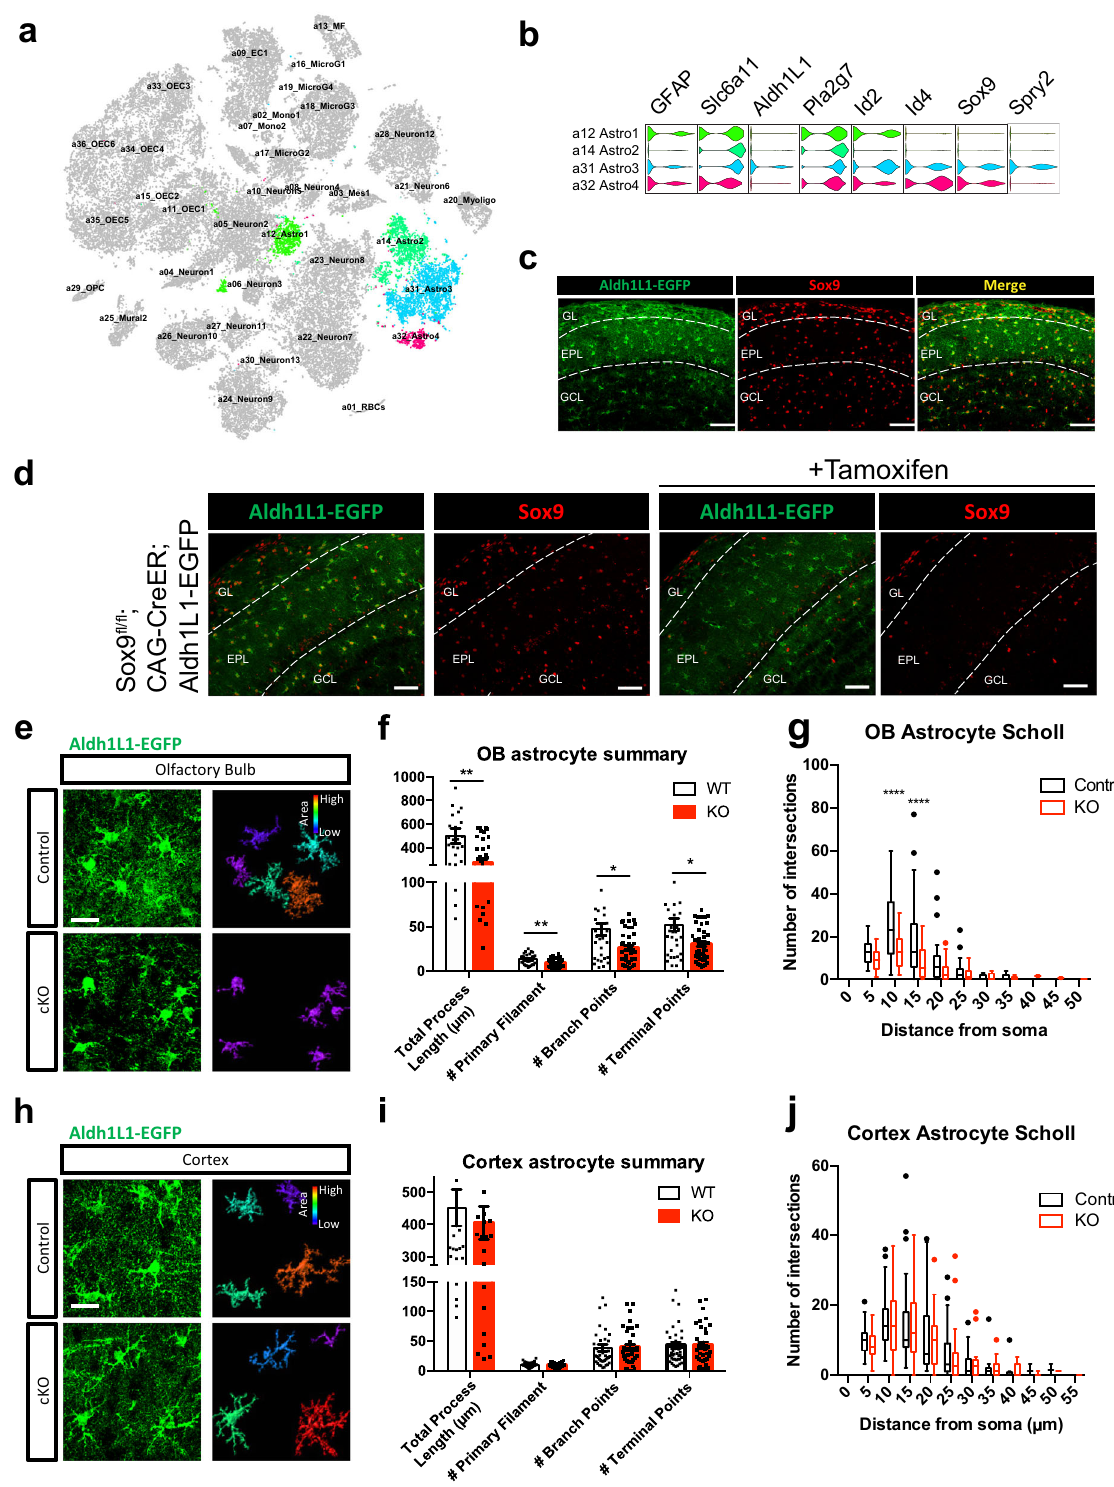
conditional AAV-GFAP- fl ex-GCaMP6m into the OB of Sox9 fl / fl mice to drive genetic deletion of Sox9 as well as targeted expression of GCaMP6m (Fig. 2a). Similar injections into C57BL/ 6 J mice (WT) served as controls. Injection in the OB resulted in high ef fi ciency KO of Sox9 (39.14 ± 5.381% Sox9 + ; Aldh1L1- EGFP + astrocytes in Sox9 fl / fl ; Aldh1L1-EGFP animals vs 86.51 ± 4.67% in Aldh1L1-EGFP controls) (Fig. S2c – e) as well as